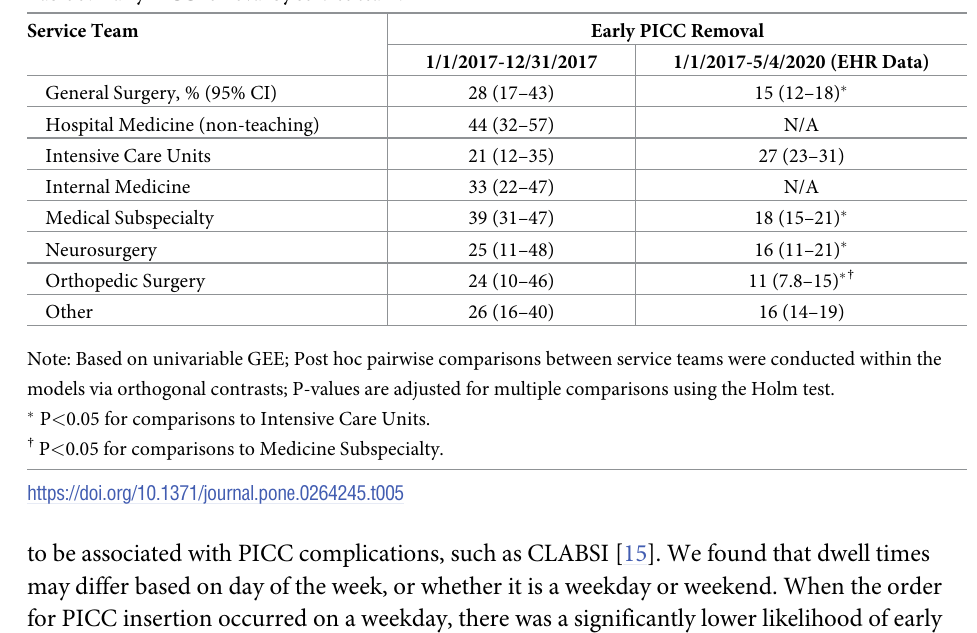
Table 5. Early PICC removal by service